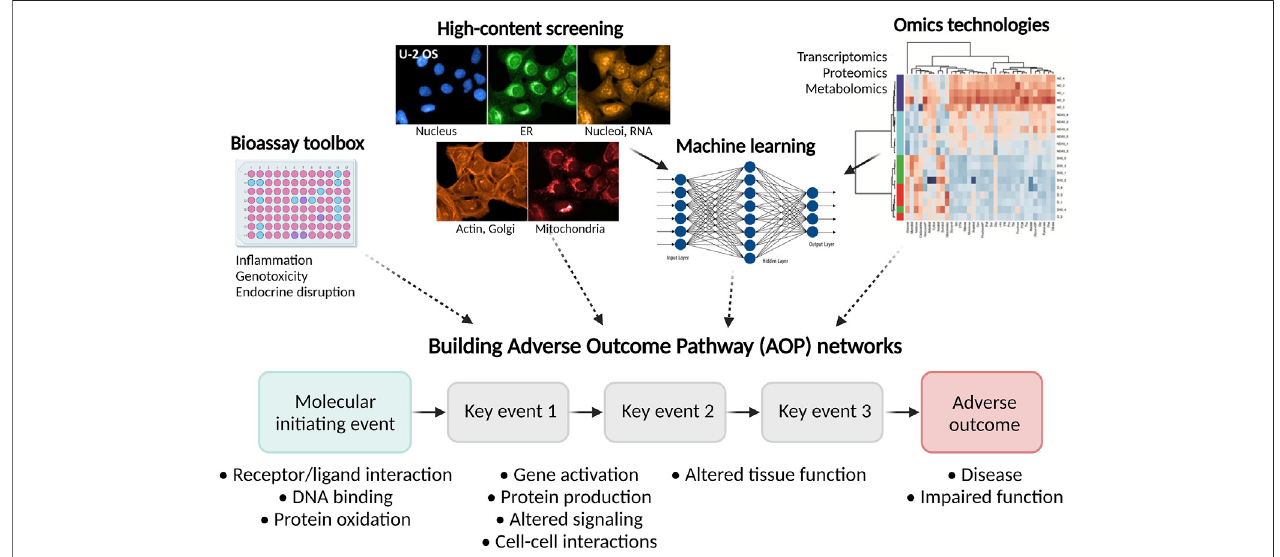
FIGURE7| Next-generationtoxicologytestingfortheparticlesafetyassessment.Integrationofthebioassaytoolbox,high-contentscreening,omicstechnologies, and machine learning models offers excellent input in the development of AOP networks and description of MIEs, KEs, and